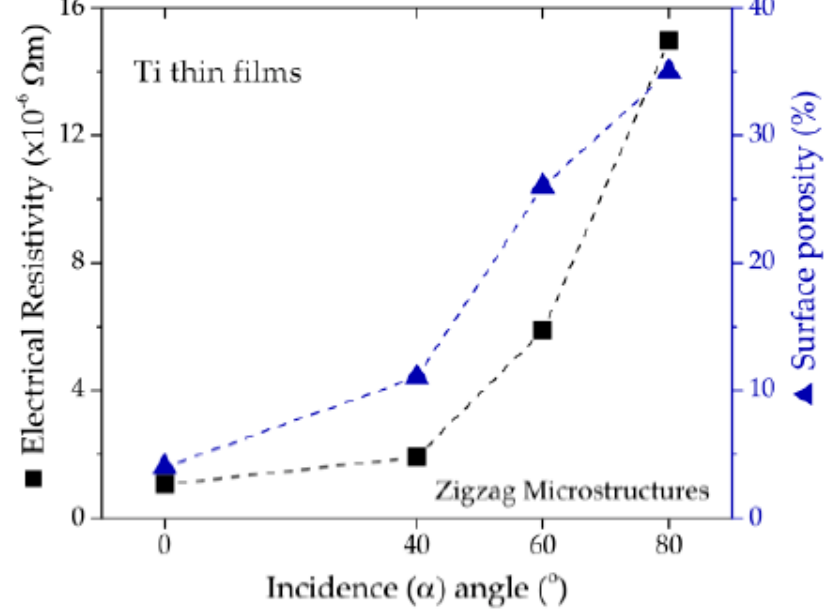
Figure 6. Electrical resistivity and surface porosity of the thin films as a function of the incidence α angle.